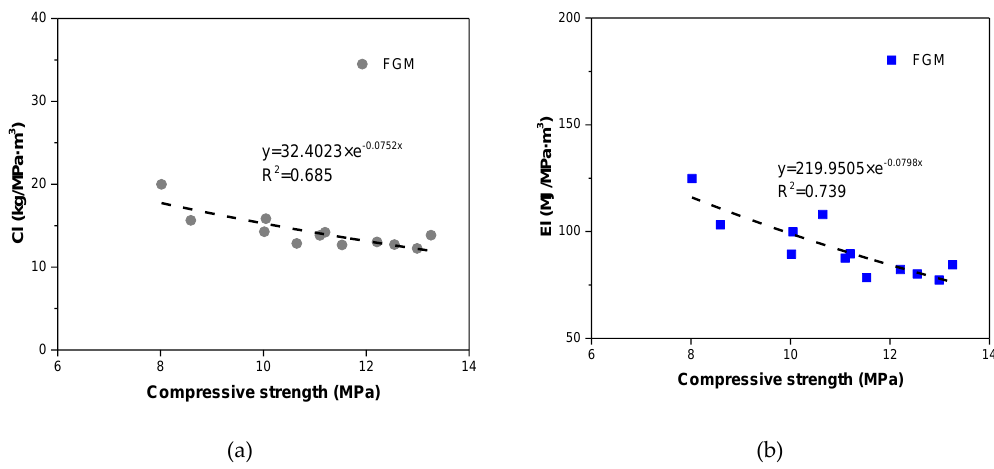
Figure 10. Relationship between greenness indices and compressive strength in FGM. ( a ) Relationship between CI and compressive strength in FGM; ( b ) Relationship between EI and compressive strength in FGM.